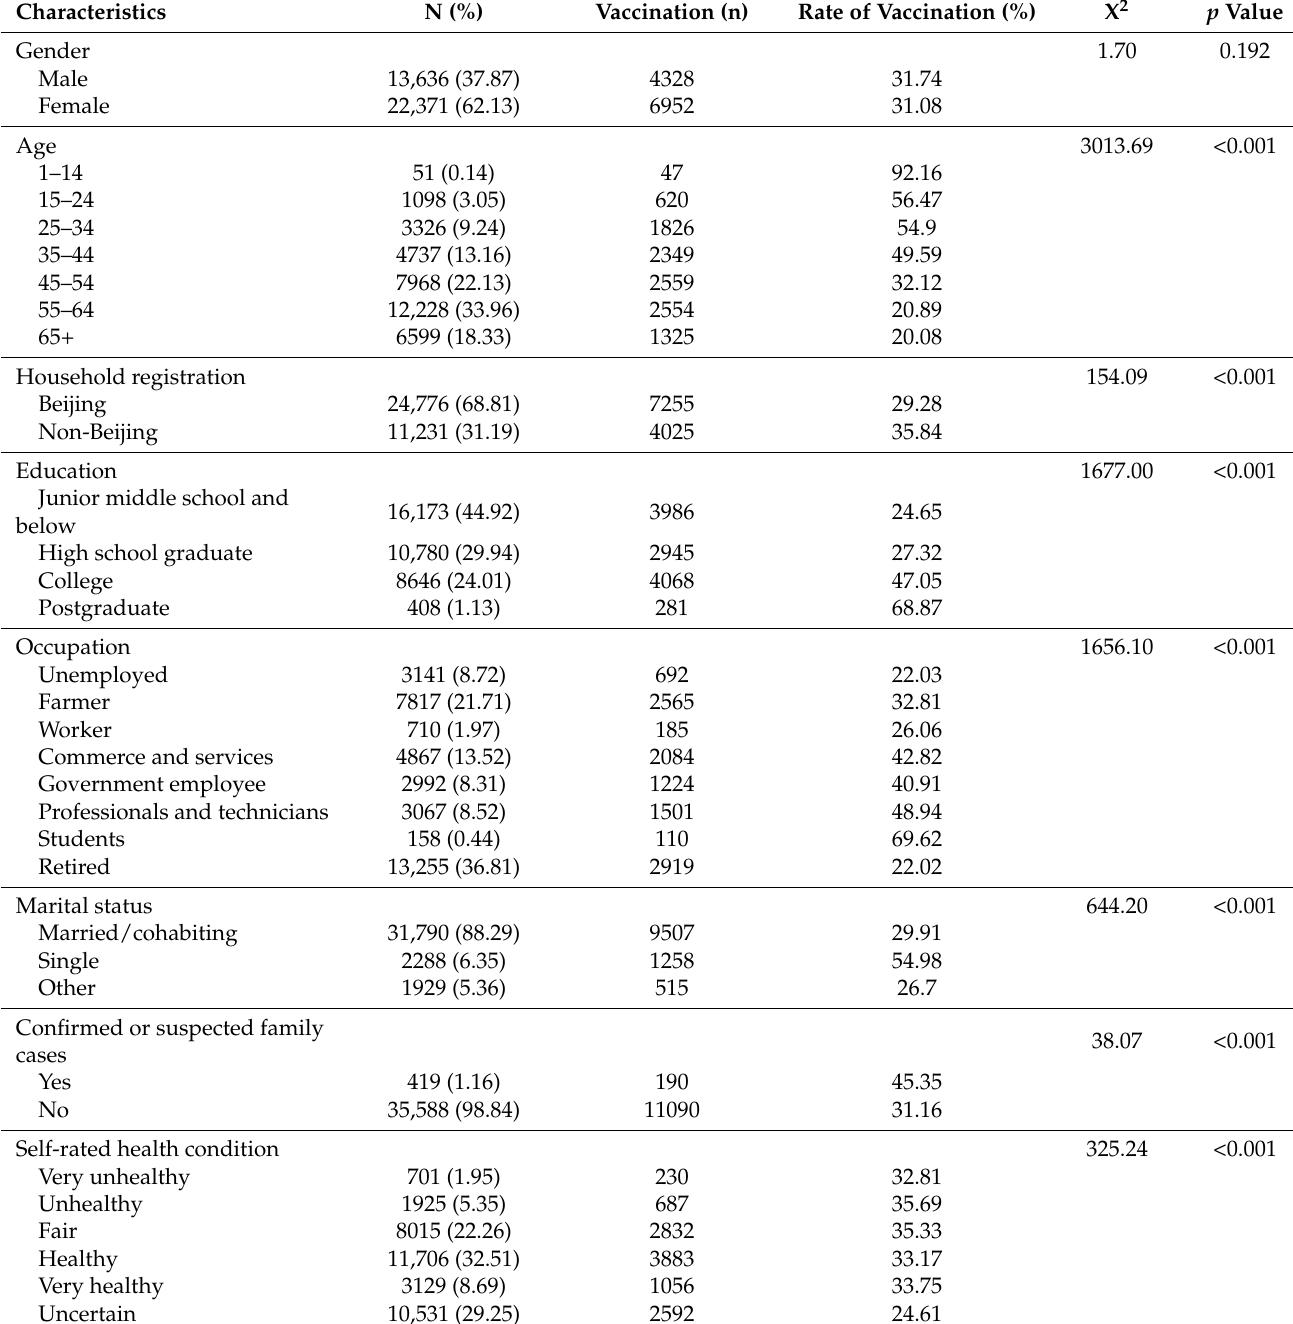
Table 1. Characteristics of respondents in Chaoyang District,